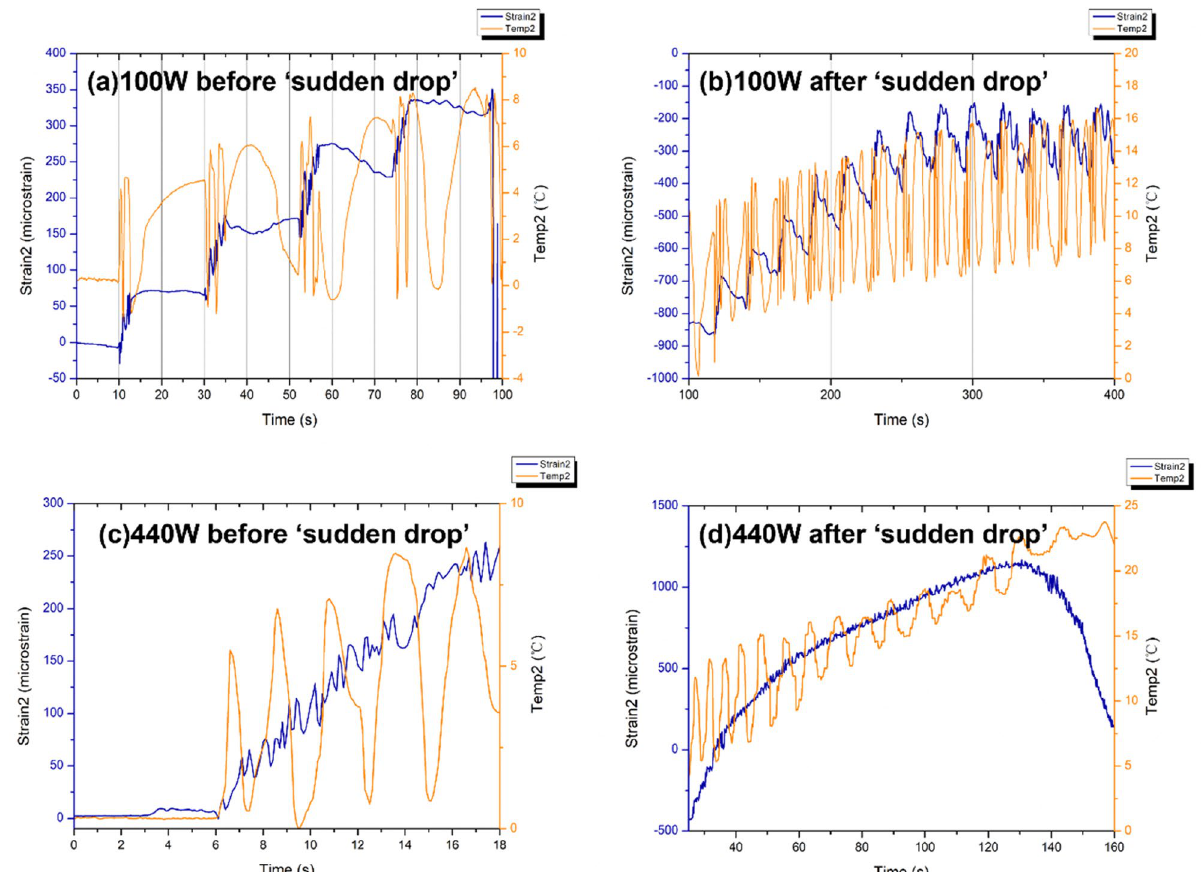
Figure 22. Strain and temperature variations measured by sensor 2 before and after the ‘sudden drop’ at 100 W ( a , b ) and 440 W ( c , d Despite the widely known utilisation of FBG strain sensors, there exists a layer of adhesive and protective coating that may affect the data from the nanocomposite 102 . The FBG sensors are adhesively bonded to the surface of specimens by PERMABOND 920 Cyanoacrylate. The dielectric and thermal properties of the adhesive and neat epoxy are presented in Table 2. Five FBG sensor arrays, 20 mm apart, were utilised to quantify the adhesive’s response distribution. Figure 24 presents the strain and temperature change measured via sensors bonded to a PTFE block with adhesive under 100 W and 440 W. It can be observed from Fig. 24 that temperature increases in the adhesive with microwave exposure time at both power levels as predicted while the temperature rise has a higher rate under 400 W. The maximum temperature changes are around 7 °C and 4.5 °C for 100 W and 440 W, respectively. The insignificant amount of temperature rise is the direct evidence of relative less interaction of adhesive and microwave. The strain values steadily increase with the temperature rise in both cases due to the thermal expansion of PTFE and adhesive. The calculated thermal strain of PTFE based on Fig. 24 and Table 2 under 100 W is approx. 868 micro-strain at 7 °C temperature change. The calculated value is almost consistent with the measured value of strain sensor 1 which is approx. 960 micro-strain at similar temperature variation range. Unlike 100 W, the measured strain of sensor 1 in 440 W shown as the blue line (when microwaves are removed) is approximately 10 micro-strain, which is much lower than 458 microstrain, the calculated thermal strain of PTFE at the same temperature change (3.7 °C). At the microwave exposure, the adhesive solely interacts with the microwave, and is heated up owing to its higher dielectric loss compared with the PTFE. However, the PTFE have a higher CTE than the adhesive. Consequently, the measured strain under 100 W is mainly attributed to the thermal expansion of PTFE from the conduction of heat. The strain sensors under 100 W showed strain increase initiated after 200 s, indicating that a substantial amount of time is required to trigger the heating conduction between the adhesive and PTFE. On the contrary, 440 W has a higher rate of temperature rise within 110 s exposure. Based on the analysis of the calculated and measured strain, the strain under 100 W is mainly attributed to PTFE thermal expansion while the strain under 440 W is dominated by the thermal expansion of adhesive. Under 440 W, a similar trend in temperature rise is noted between sensors 1 and 3, as well as sensor 2 and 4, which is described by the ‘hot spot’ theory due to non-uniform microwave field. Neat Epoxy FBG data: